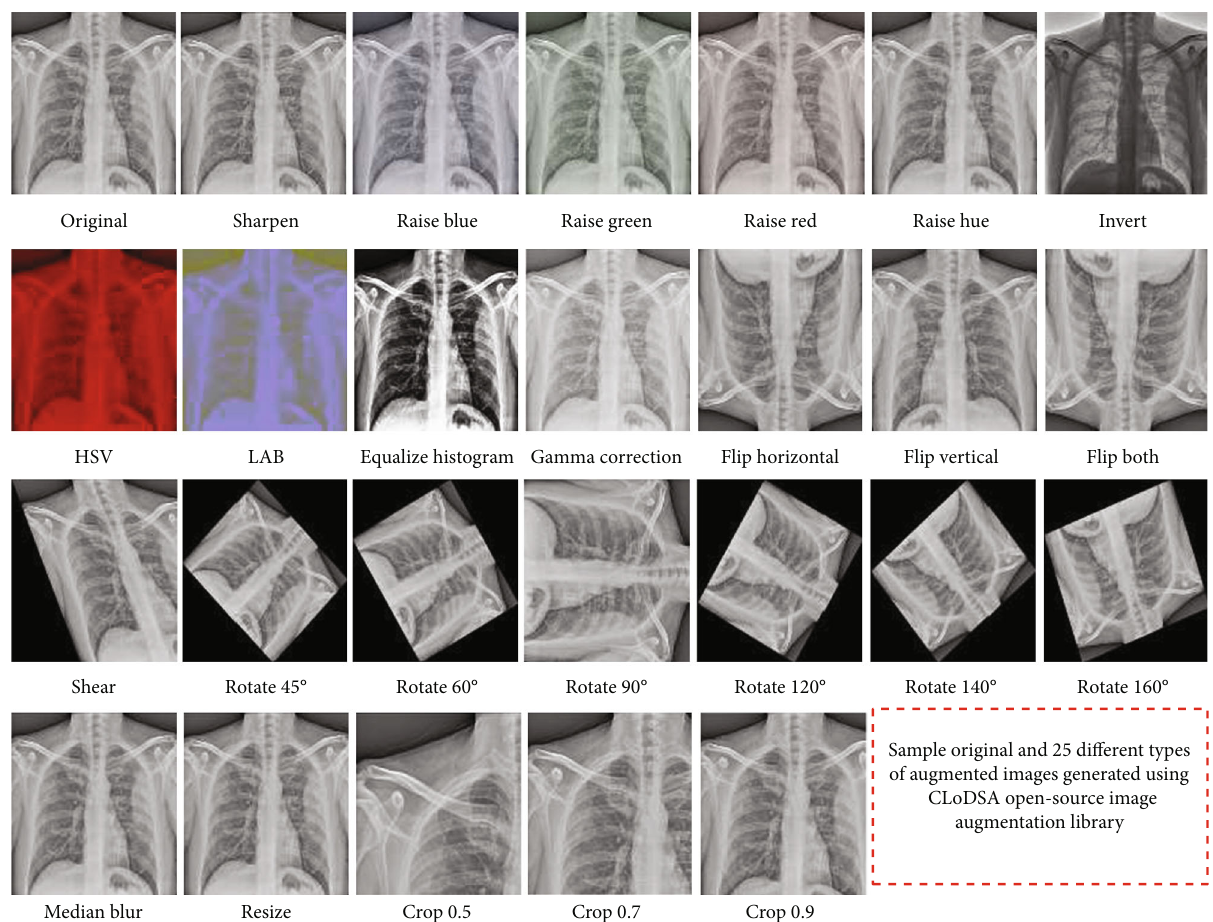
Figure 1: Sample original and 25 di ff erent types of augmented images (generated through open-source, image augmentation library —